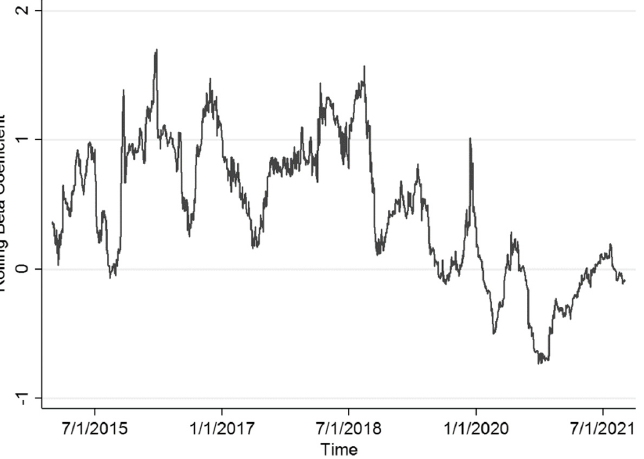
Figure 6. Common shock (rolling) impact on the Banco BPM performance: period January 2015–